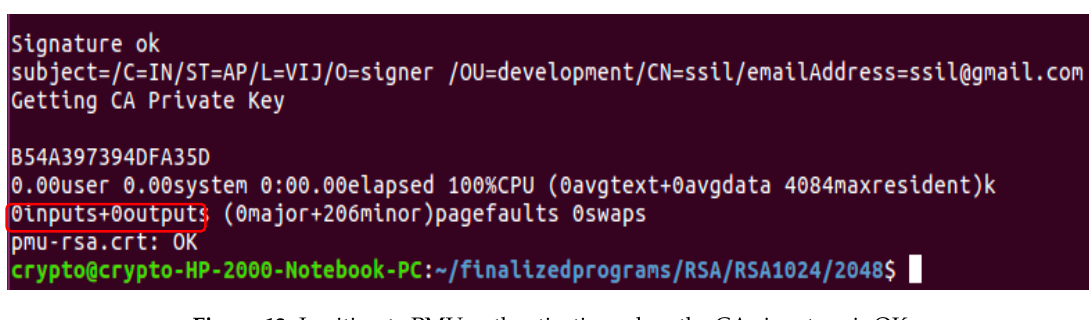
Figure 12. Legitimate PMU authentication when the CA signature is OK.